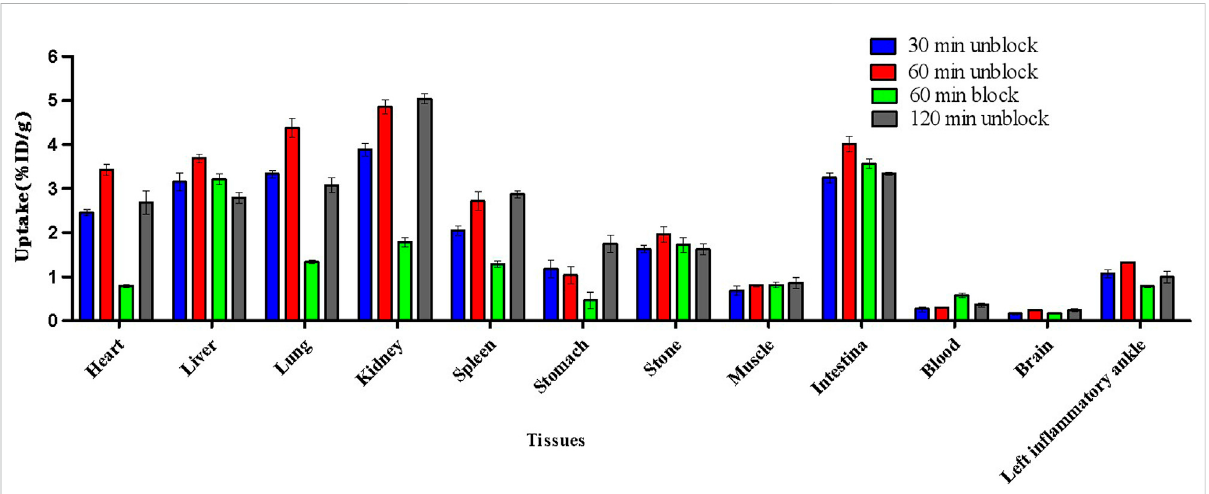
FIGURE 5 Biodistribution results for 18 F-VUIIS1008 on day 3 after CFA injection. Data are presented as %ID/g at various times post-injection of 18 F-VUIIS1008.